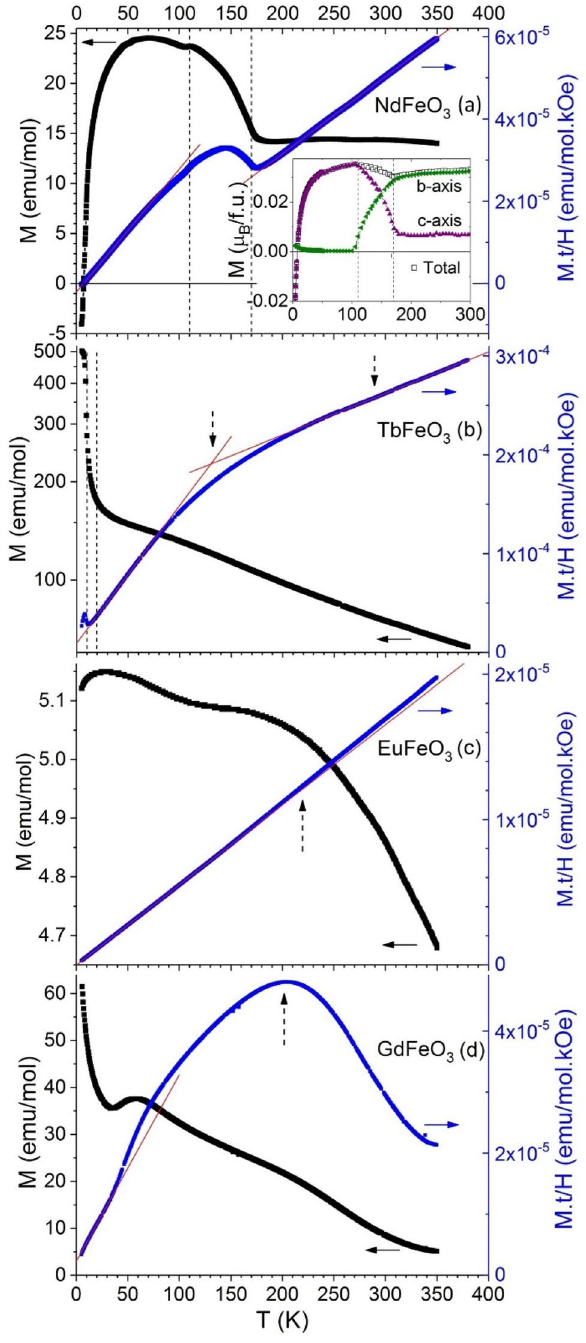
Figure 1. Left axes: temperature dependence of the magnetization of ( a ) NdFeO 3 under FC conditions, and ( b ) TbFeO 3 , ( c ) EuFeO 3 and ( d ) GdFeO 3 , under ZFC conditions, measured in heating under 40 Oe. Inset of ( a ) shows similar M(T) data for a NdFeO 3 single crystal from Ref. 7 . Right axes: M.t/H (t = T/T N ) versus temperature for the same compounds. Vertical dashed lines mark the phase transition temperatures following Ref. 13 , while vertical dashed arrows mark relevant